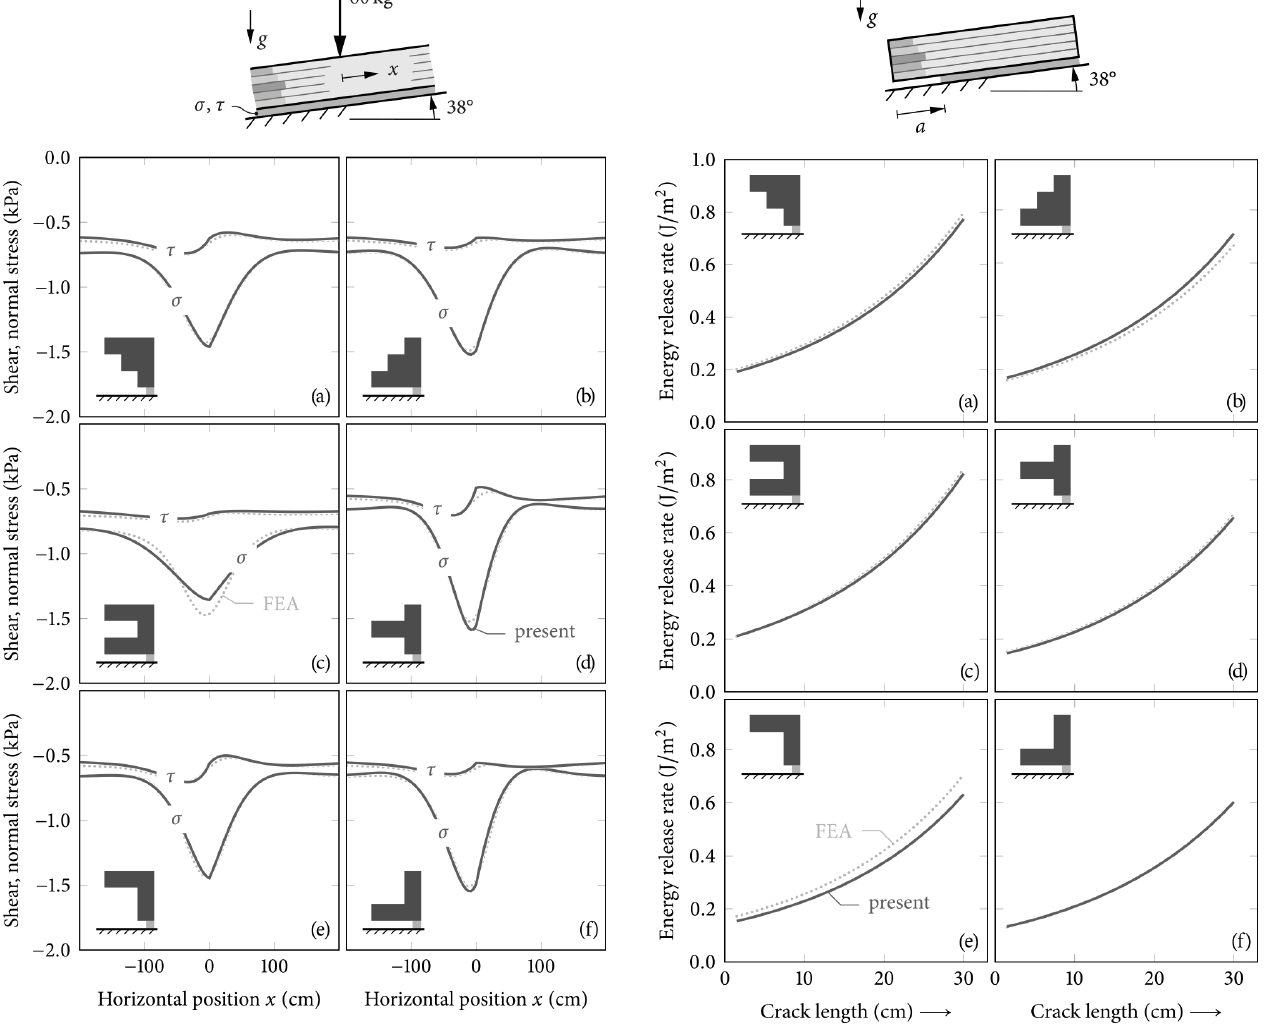
Figure 9. Total energy release rates of weak-layer anticracks in 38 ◦ inclined PST experiments of 120cm length with the benchmark pro- files illustrated in Fig. 5. The present solution (solid, dark) and FEA reference (dotted, light) are in good agreement. Material properties are given in Tables 1 and